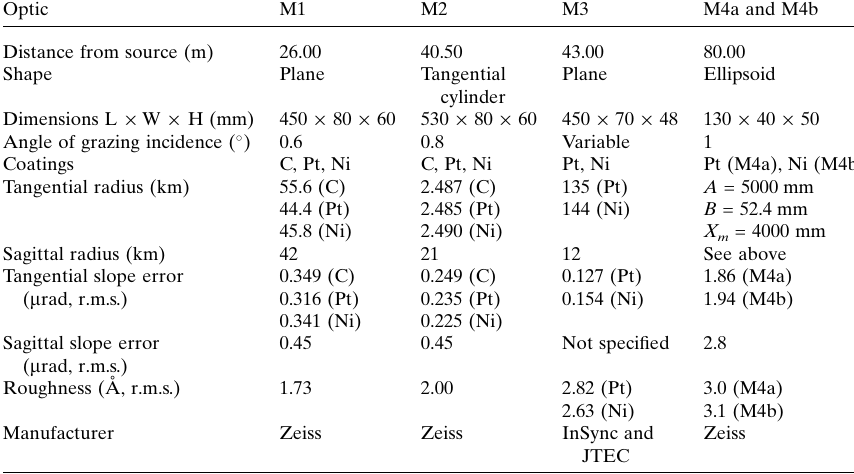
Table 1 List of all mirrors up to the sample position. Note that for M1, M2 and M3, any parameters with multiple values represent the measurement performed at different coating stripes. For mirror M4, they represent the measurement performed on the individual M4a or M4b mirror.